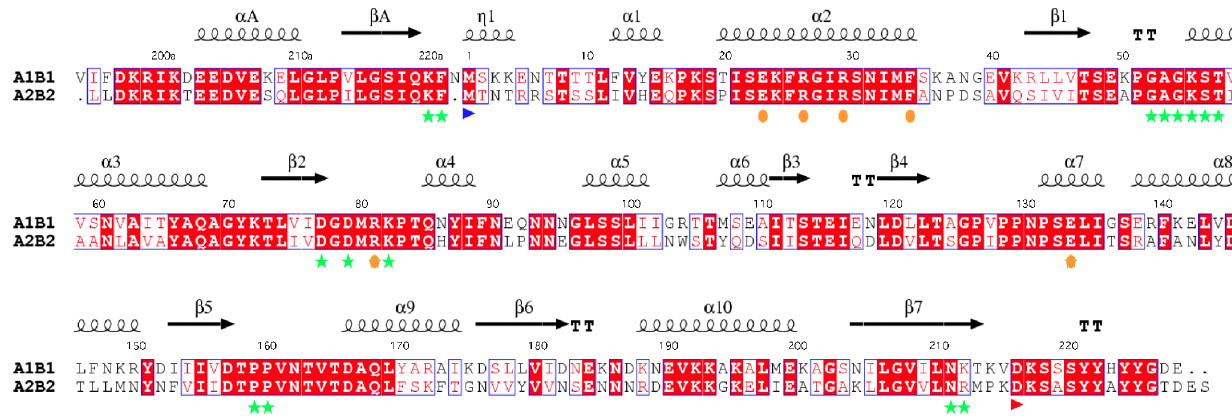
Figure 2. CapA1B1/CapA2B2 sequence comparison. The sequences of the chimera CapA1B1 and CapA2B2 have been aligned using ClustalW [32]. The conserved secondary structure elements as well as the 3 10 -helix g 1 only observed in the CapA1B2 structure (PDB IDs 2VED and 3BFV) are indicated at the top of the alignment. using Esprit [33]. Residue numbering of CapA1B1 is indicated with CapA1 residues numbered from V194a to N222a and CapB1 residues numbered from M1 to E228. The N-terminal methionine of CapB1 and CapB2 is highlighted by a blue arrow. The active site residues involved in nucleotide binding (including the Walker A motif and the catalytic lysine K55) are highlighted by green stars. The conserved interface residues including the conserved EX 2 RX 2 R motif in helix a 2 are highlighted by orange dots. The first residue of the Y-cluster is indicated by a red arrow.